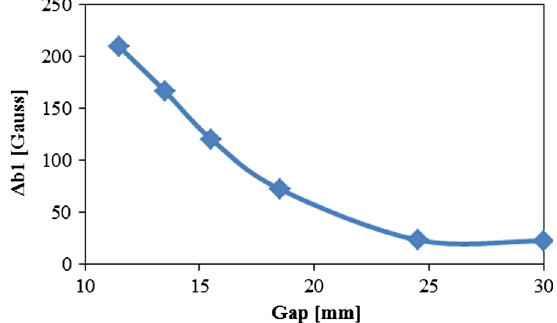
FIG. 3. Difference of the normal integrated quadrupole com- ponent [b 1 ð 180 ° Þ − b 1 ð 0 ° Þ ] between the rotated and nonrotated ID UNA33